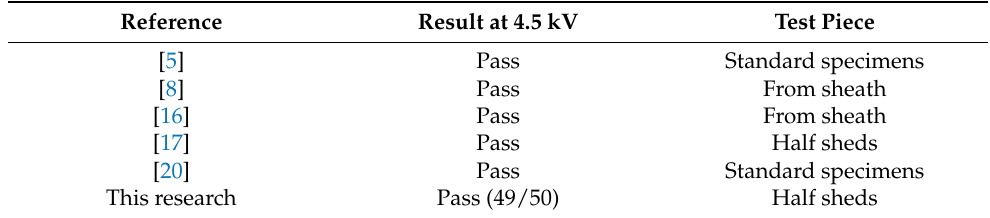
Table 7. Comparative study and contribution to the results of inclined plane test, at the most intense voltage level of IEC 60587 standard (4.5 kV) [15], on new (unused) HTV silicone rubber with ATH filler used as composite insulators’ housing material and the corresponding types of test pieces